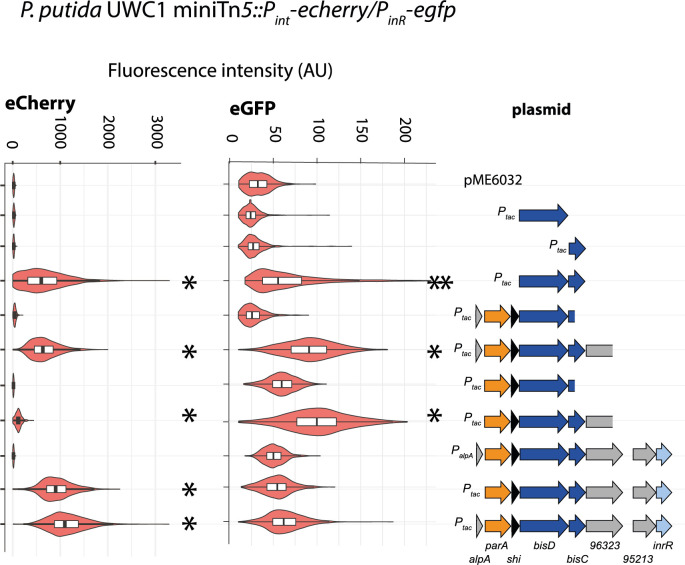
Effect of bisDC containing plasmid constructs on fluorescent protein expression from a single copy dual Pint-PinR reporter in P. putida without ICEclc.Diagrams show distributions of individual cell fluorescence of P. putida from Pint (eCherry) and PinR (eGFP), complemented with the indicated plasmid constructs (on the right), upon induction with 0.05 mM IPTG. Distributions represented by box plots (black on white, with first quartile, median and second quartile), underlaid with a violin distribution of all data (salmon red). Single asterisks indicate statistically significant differences of median values compared to P. putida carrying the empty vector in pair-wise t-test of biological triplicates (p<0.05), whereas double asterisks indicate statistically significant differences of the measured subpopulations in quantile-quantile plots.